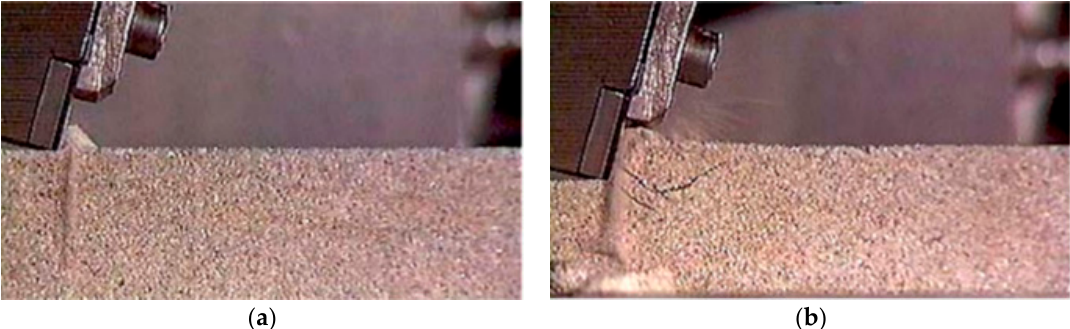
Figure 1. ( a ) Ductile mode scratching (d = 1 mm) and ( b ) brittle mode scratching (d = 4 mm) for Berea Sandstone [5].